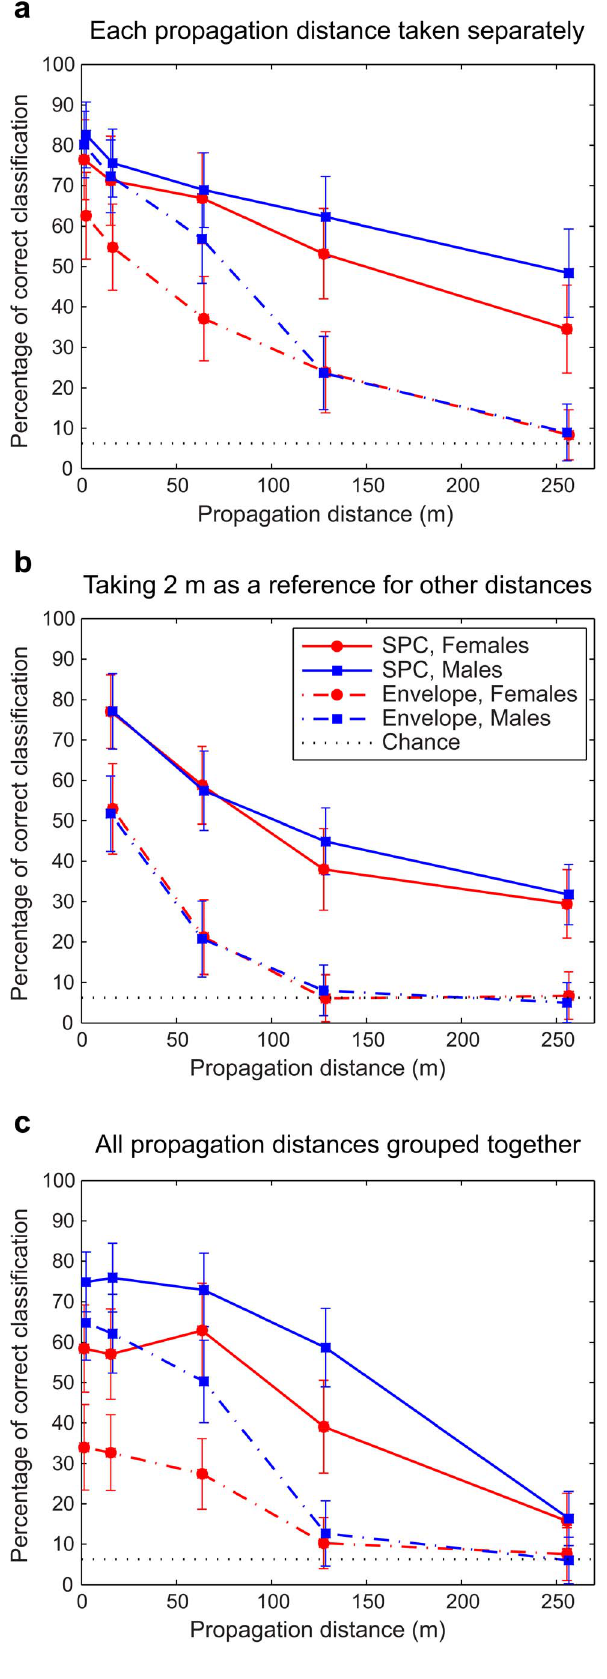
Figure 7. Mean percentages of correct classification obtained for each propagation distance and both sexes. (a) Taking the data for each propagation distance separately, (b) taking the 2 m data as a reference for other distances, and (c) taking all propagation distances into account. SPC parameters are represented as solid lines and envelope parameters as dash-dot lines. Standard deviations are indicated. The chance level, corresponding to 6.25% of correct classification, is shown as a horizontal dotted